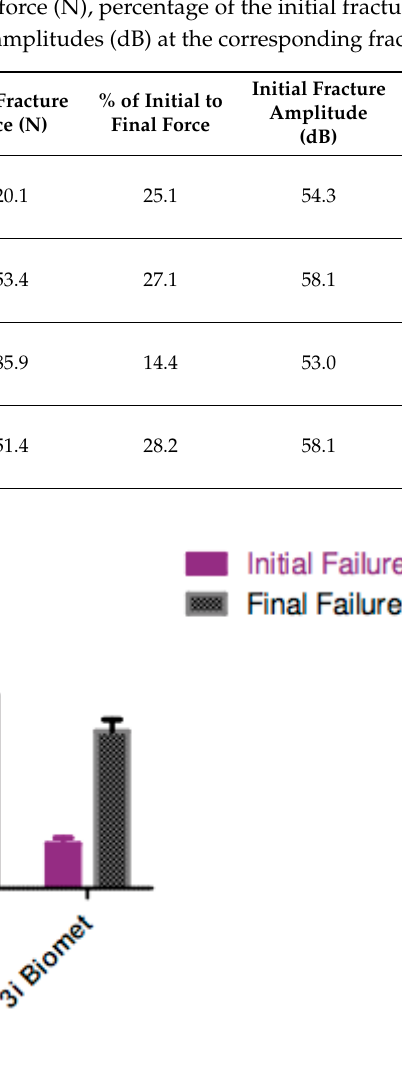
Table 2. Means of the initial and final fracture force (N), percentage of the initial fracture force to its final fracture force and the respective acoustic amplitudes (dB) at the corresponding fractures. Table 2 is not mentioned, please check and revise.